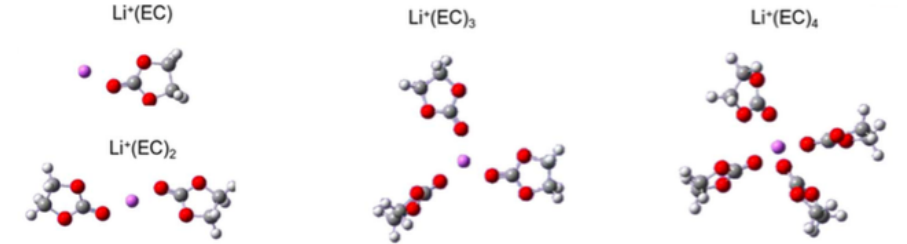
Figure 7. Geometry-optimized lithium ion–EC clusters with varying number of coordinating solvent molecules. Figure reproduced from Ref.